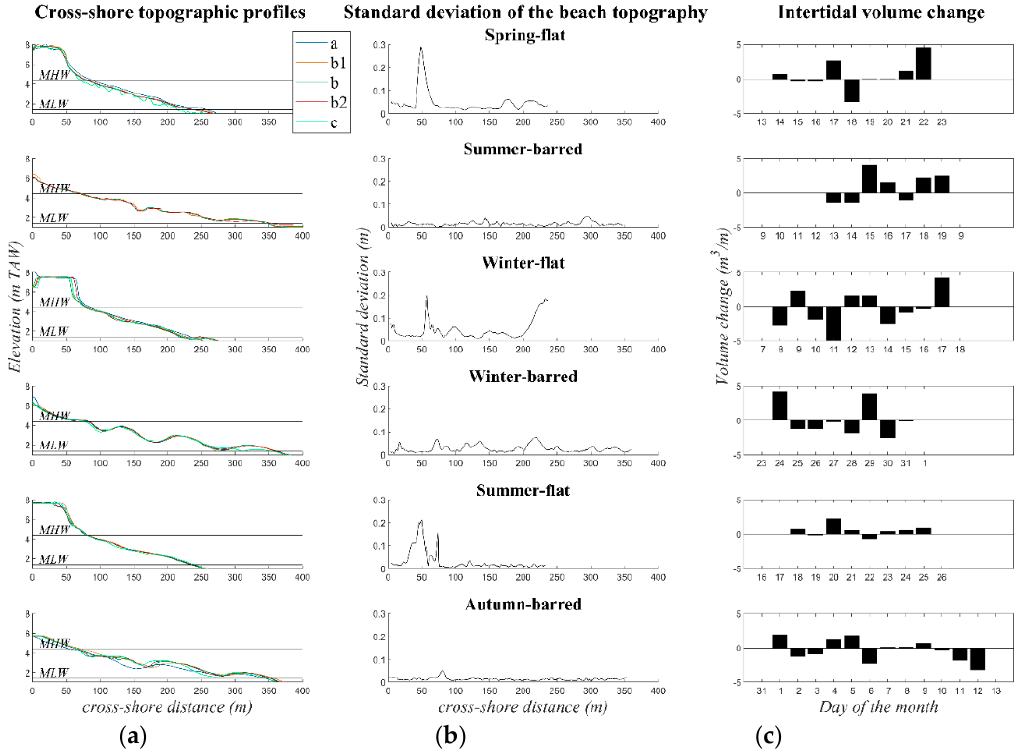
Figure 7. Beach topography. ( a ) Cross-shore topographic profiles at the start of each campaign with the MHW and MLW line indicated. ( b ) The standard deviation of the representative central profile ( b ). ( c ) Daily volumetric changes alongshore averaged.